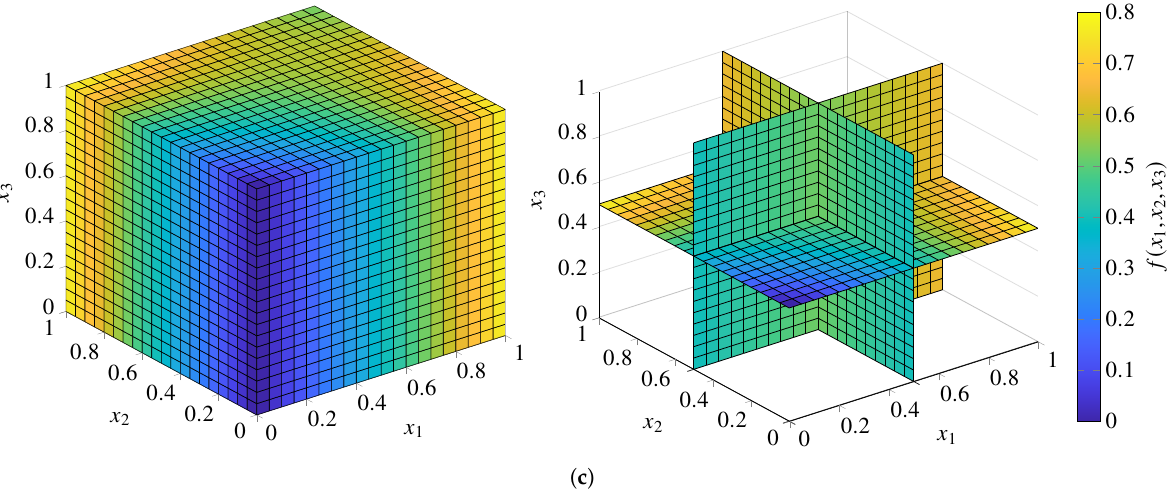
Figure 3. Examples of regular grids for ( a ) D = 1, ( b ) D = 2 and ( c ) D = 3 showing the number of vertices surrounding the point where the interpolant must be calculated. The number of vertices surrounding a point x ∗ , i = 1,2, . . . , D where the interpolant is to be calculated is 2 D i